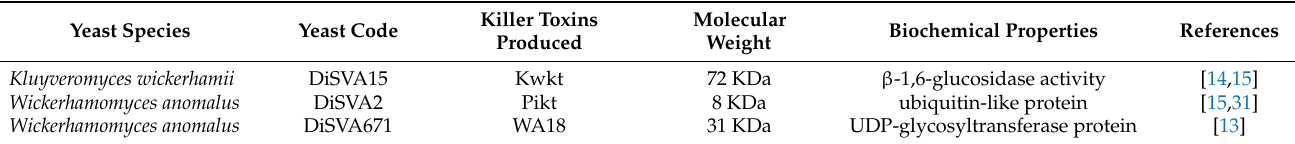
Table 4. Origin and biochemical properties of killer